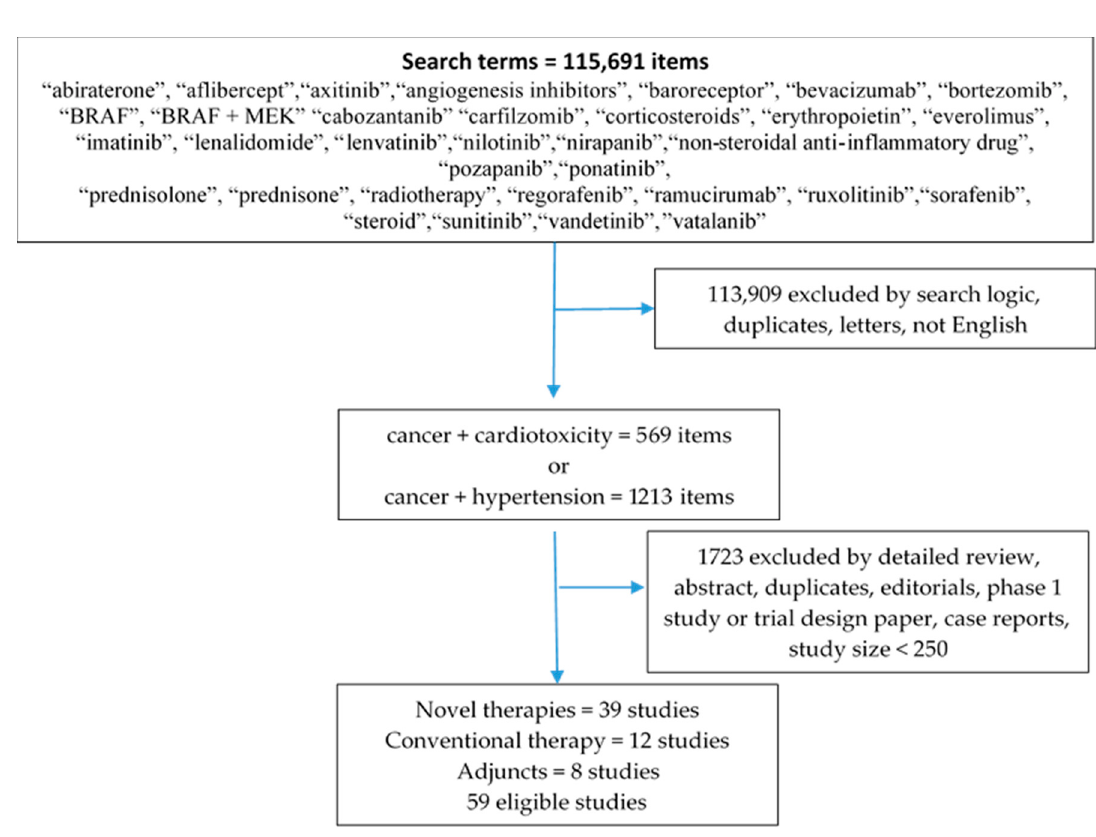
Figure A1. Search terms for conventional, adjunct and novel cancer therapies: Twenty novel (biological and tyrosine kinase inhibitor) cancer treatments known to cause > 5% new incidence of all grade hypertension, and adjunct treatments were selected by consensus; imatinib was included for historical comparison as the earliest approved oral tyrosine kinase inhibitor. The range of cancer therapies were searched against the terms “hypertension”, “cardiotoxicity”, and “cancer”. Inclusion criteria were articles published from 1990 to 2020 in English. Randomized control trials (RCT) including landmark phase 2b / 3 studies, observational clinical studies, such as cohort, case-control and cross-sectional studies, as well as meta-analyses and systematic reviews including at least 250 treated patients were included.